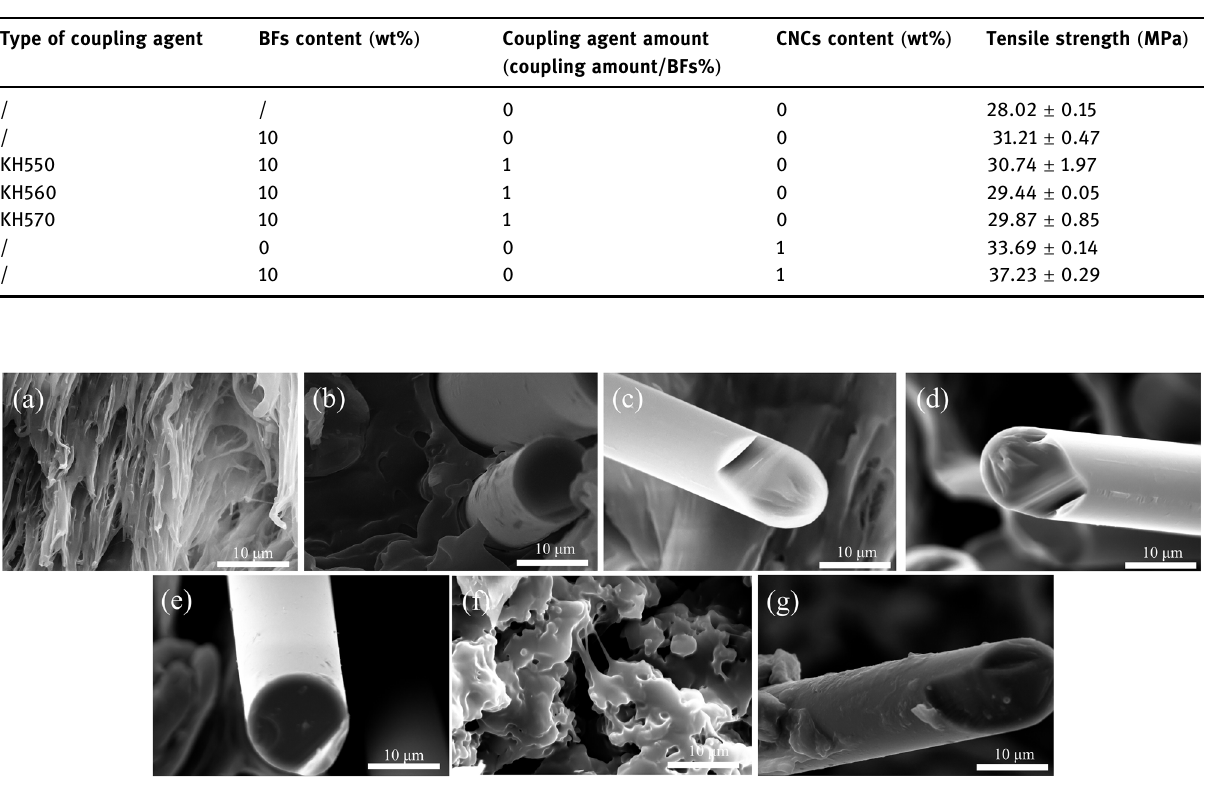
Figure 1: SEM images of tensile cross - sections of composites: ( a ) PP, ( b ) PP/10 wt% BFs, ( c ) PP/10 wt% BFs - 1.0 KH550, ( d ) PP/10 wt% BFs - 1.0 KH560, ( e ) PP/10wt % BFs - 1.0 KH570, ( f ) PP/1 wt% CNCs, and ( g ) PP/10 wt% BFs/1 wt%